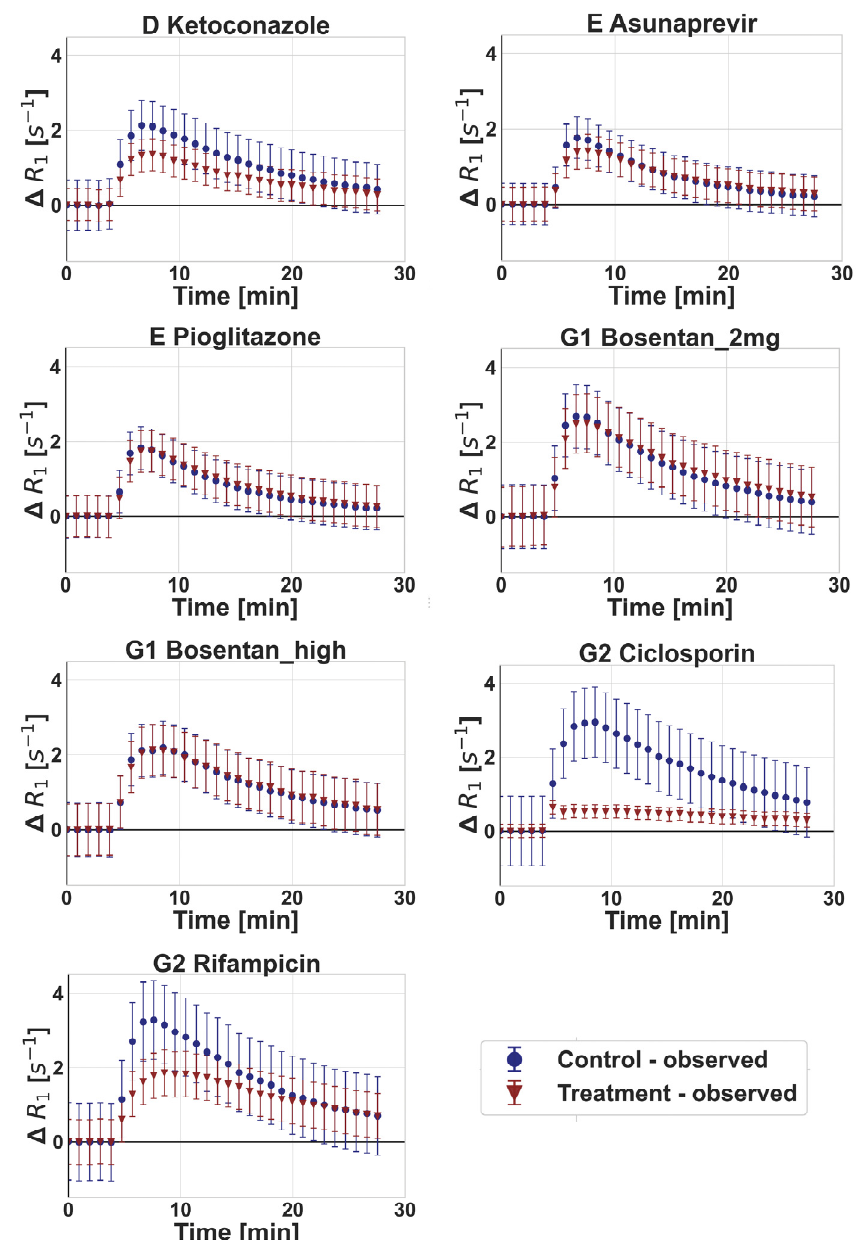
Figure 3. Observed gadoxetate liver profiles in control phase and following administration of drugs (treatment) at different sites (D, E, G1, and G2). Symbols and error bars represent mean and standard deviation (between 3 and 6 animals), respectively. Doses for each drug are listed in Table 1, where Bosentan_2mg and Bosentan_high refer to the 2 mg/kg and 4–6 mg/kg doses of bosentan, respectively.